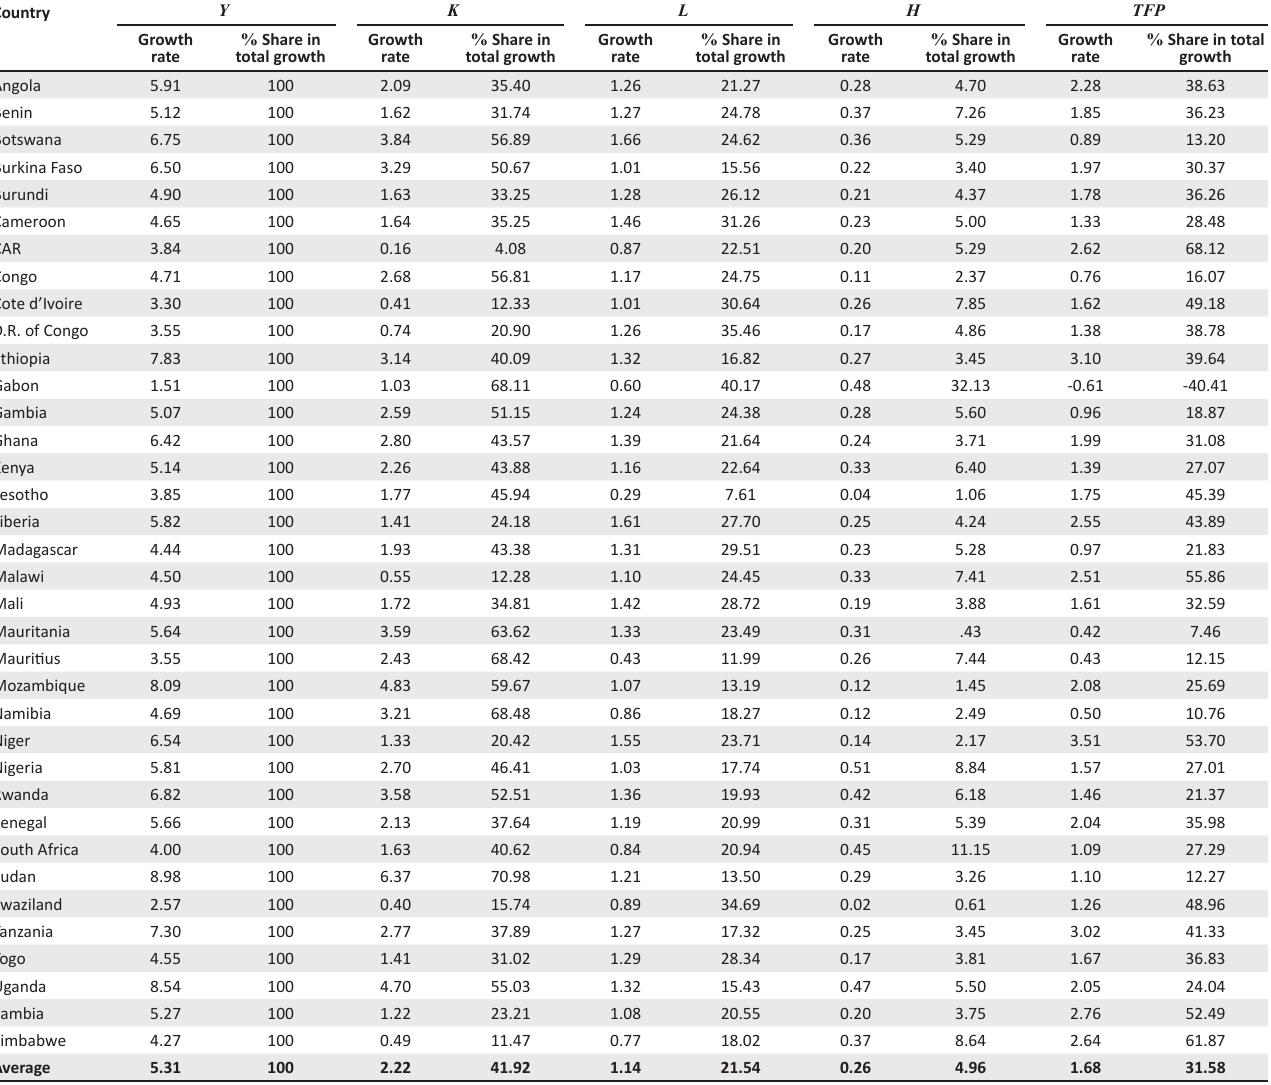
TABLE 6: Output growth decomposition in rates.